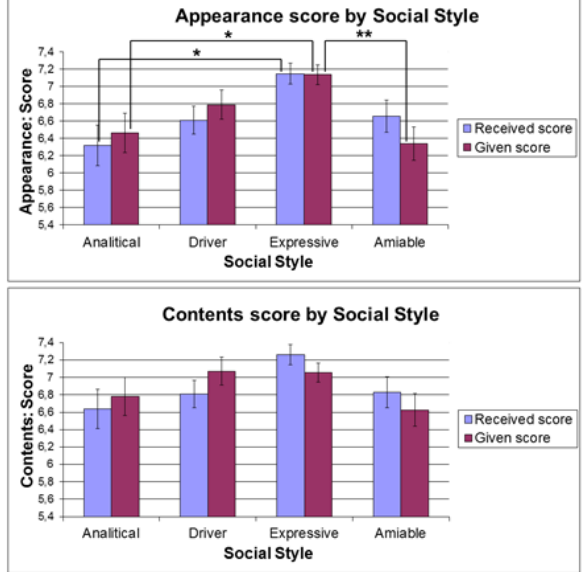
Figure 3. Results of the two-way ANOVA analysis. Split of the effect caused by the evaluators’ and speakers’ social styles (*: significant at p Bonferroni level <0.05; **: significant at p Bonferroni level <0.01; n Bonferroni =